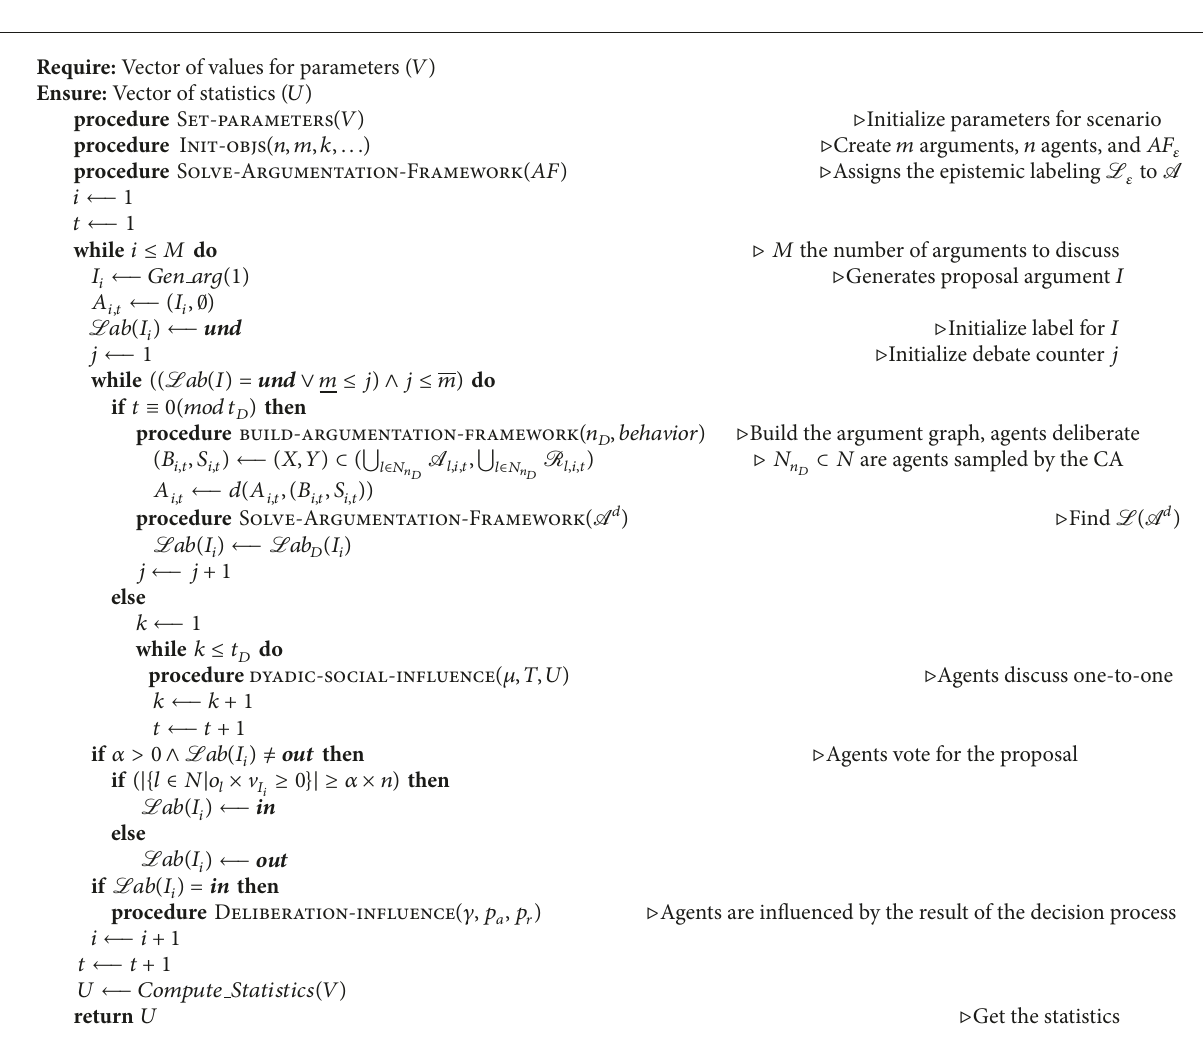
Algorithm 4: Run for one